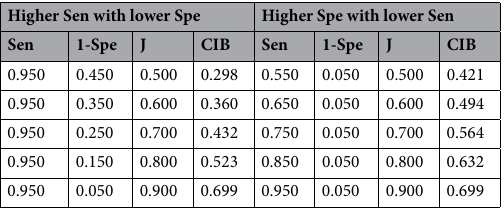
Table 2. Evaluation of sensitivity (Sen) and specificity (Spe) in a case–control study based on comprehensive index of biomarker (CIB) (Incidence = 5%).